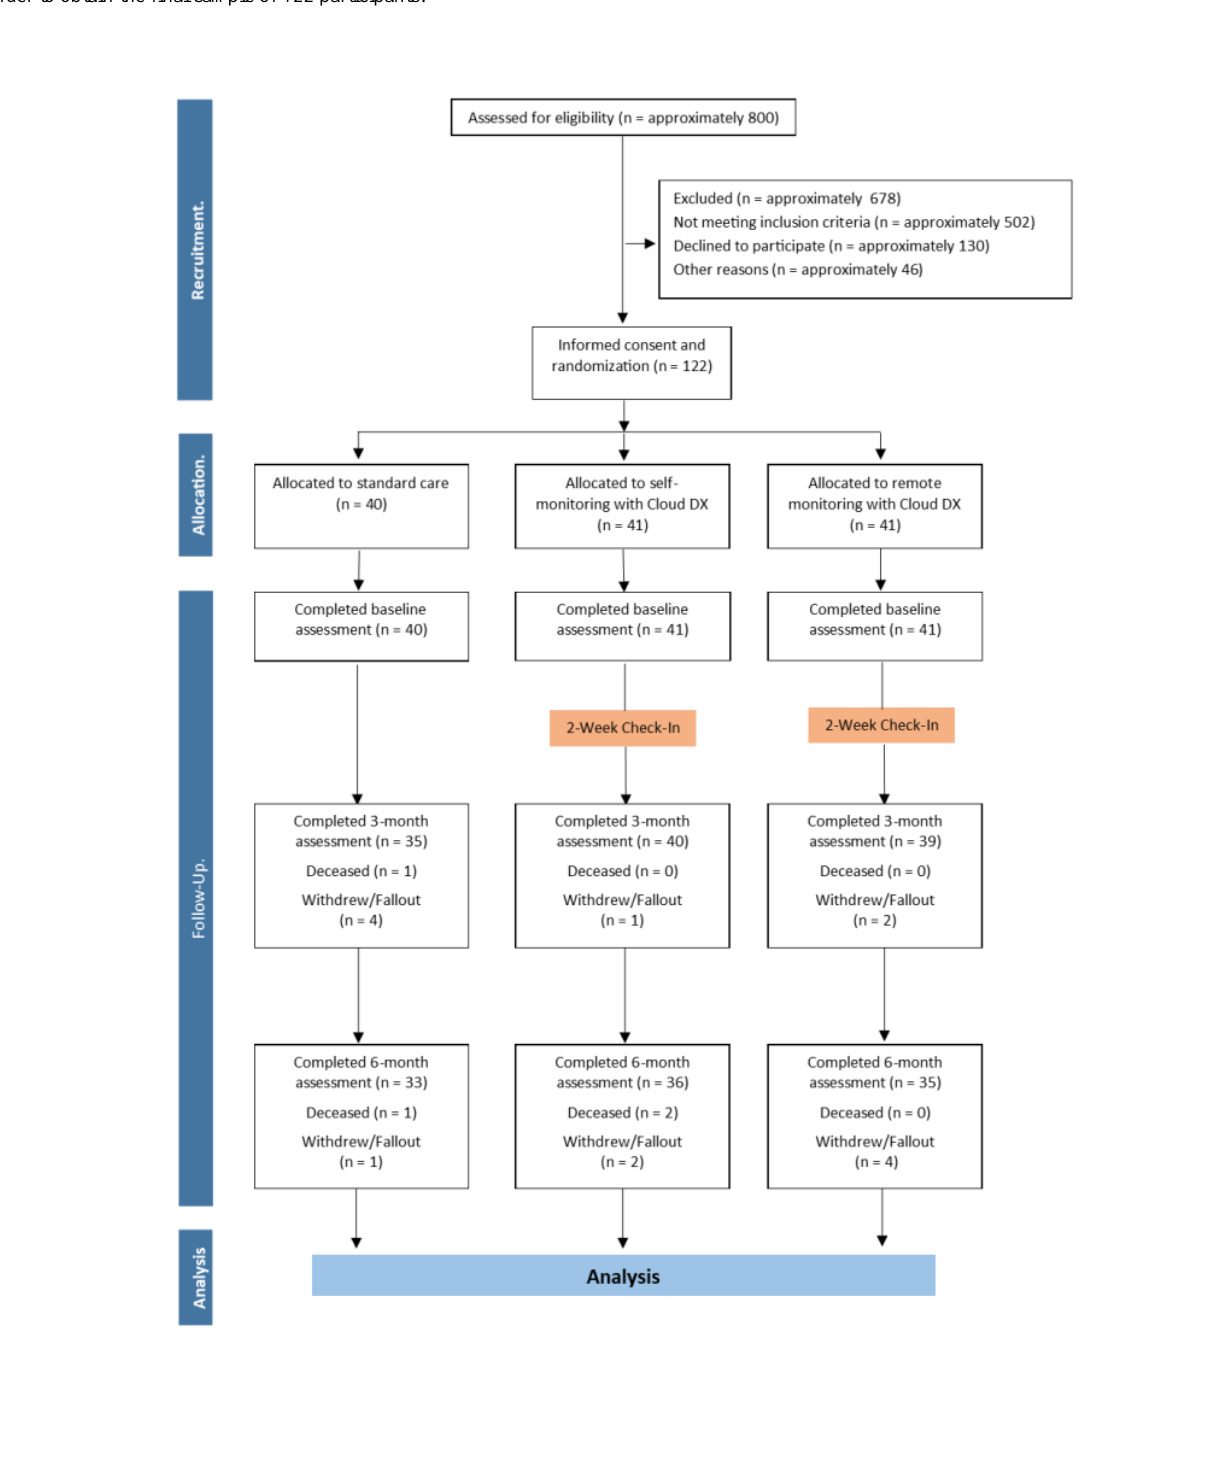
Figure 1. Patient flow through the study. Patient flow through each arm of the study. A total of approximately 800 patients were screened for eligibility in order to obtain the final sample of 122